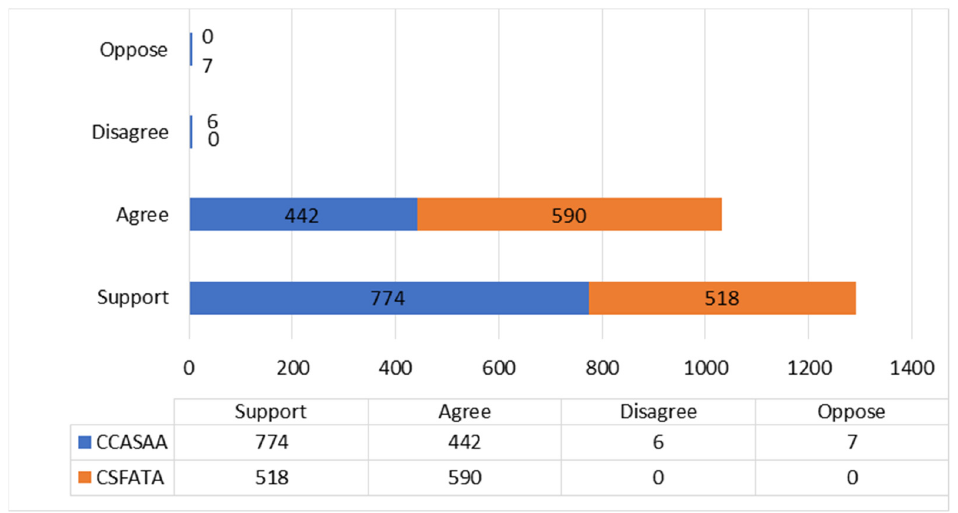
Figure 2. Engagement typology breakdown.